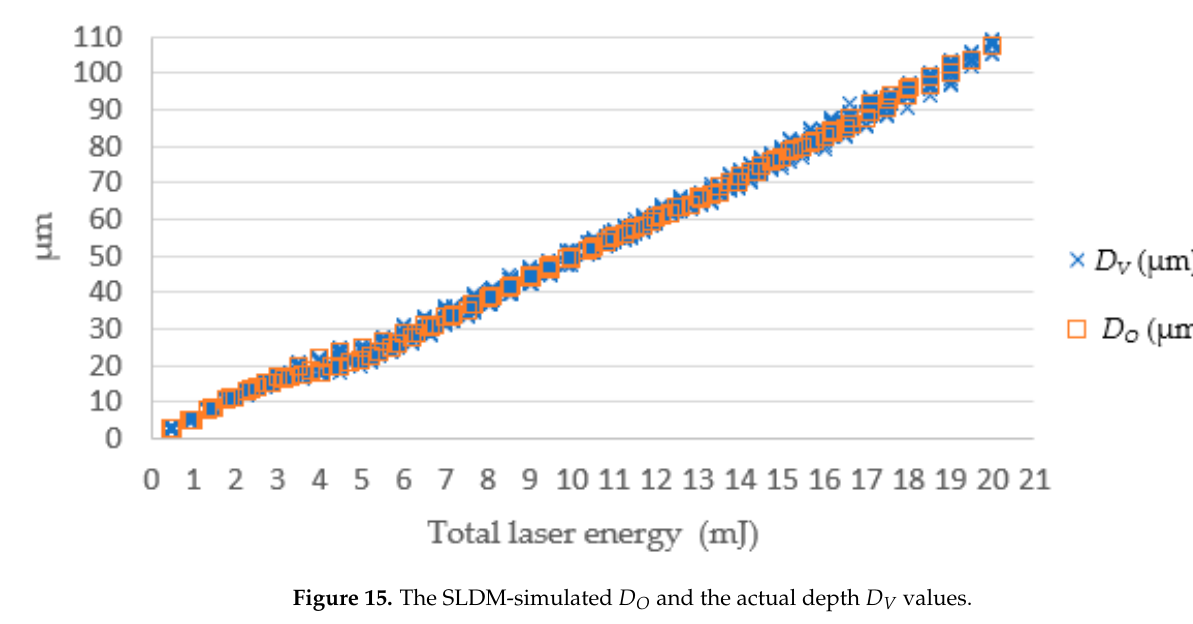
Figure 15. The SLDM-simulated D O and the actual depth D V values.